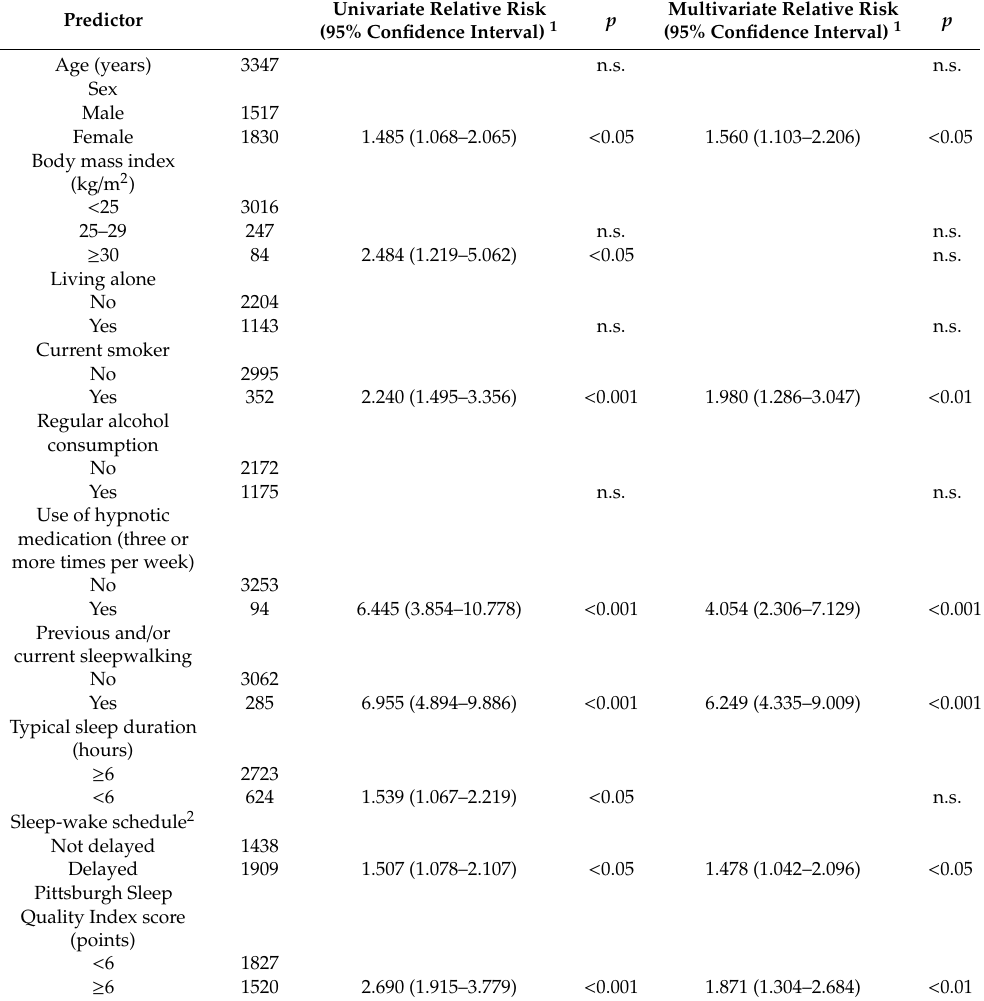
Table 2. Factors associated with nocturnal eating behavior one or more times per